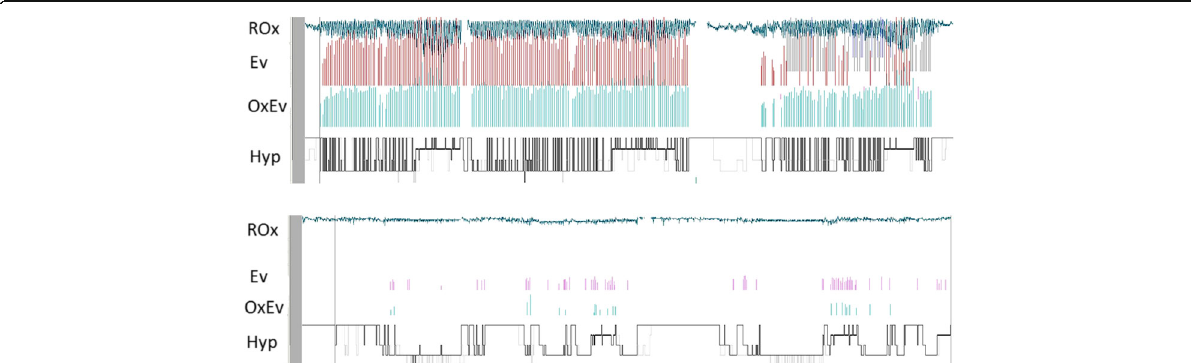
Fig. 3 Patterns of sleep fragmentation phenotype based on sleep efficiency. The upper hypnogram shows rapid sleep-wake transitions from severe sleep apnea, while the lower hypnogram shows nearly the same sleep efficiency but with consolidated periods of wake separated by consolidated periods of sleep. The % N1 is markedly increased in the patient with rapid transitions (44.2%). Thus, individual phenotypes can mix and match. ROx: raw oximetry. EV: respiratory events. OxEv: Oximetry desaturation events. Hyp: sleep stage